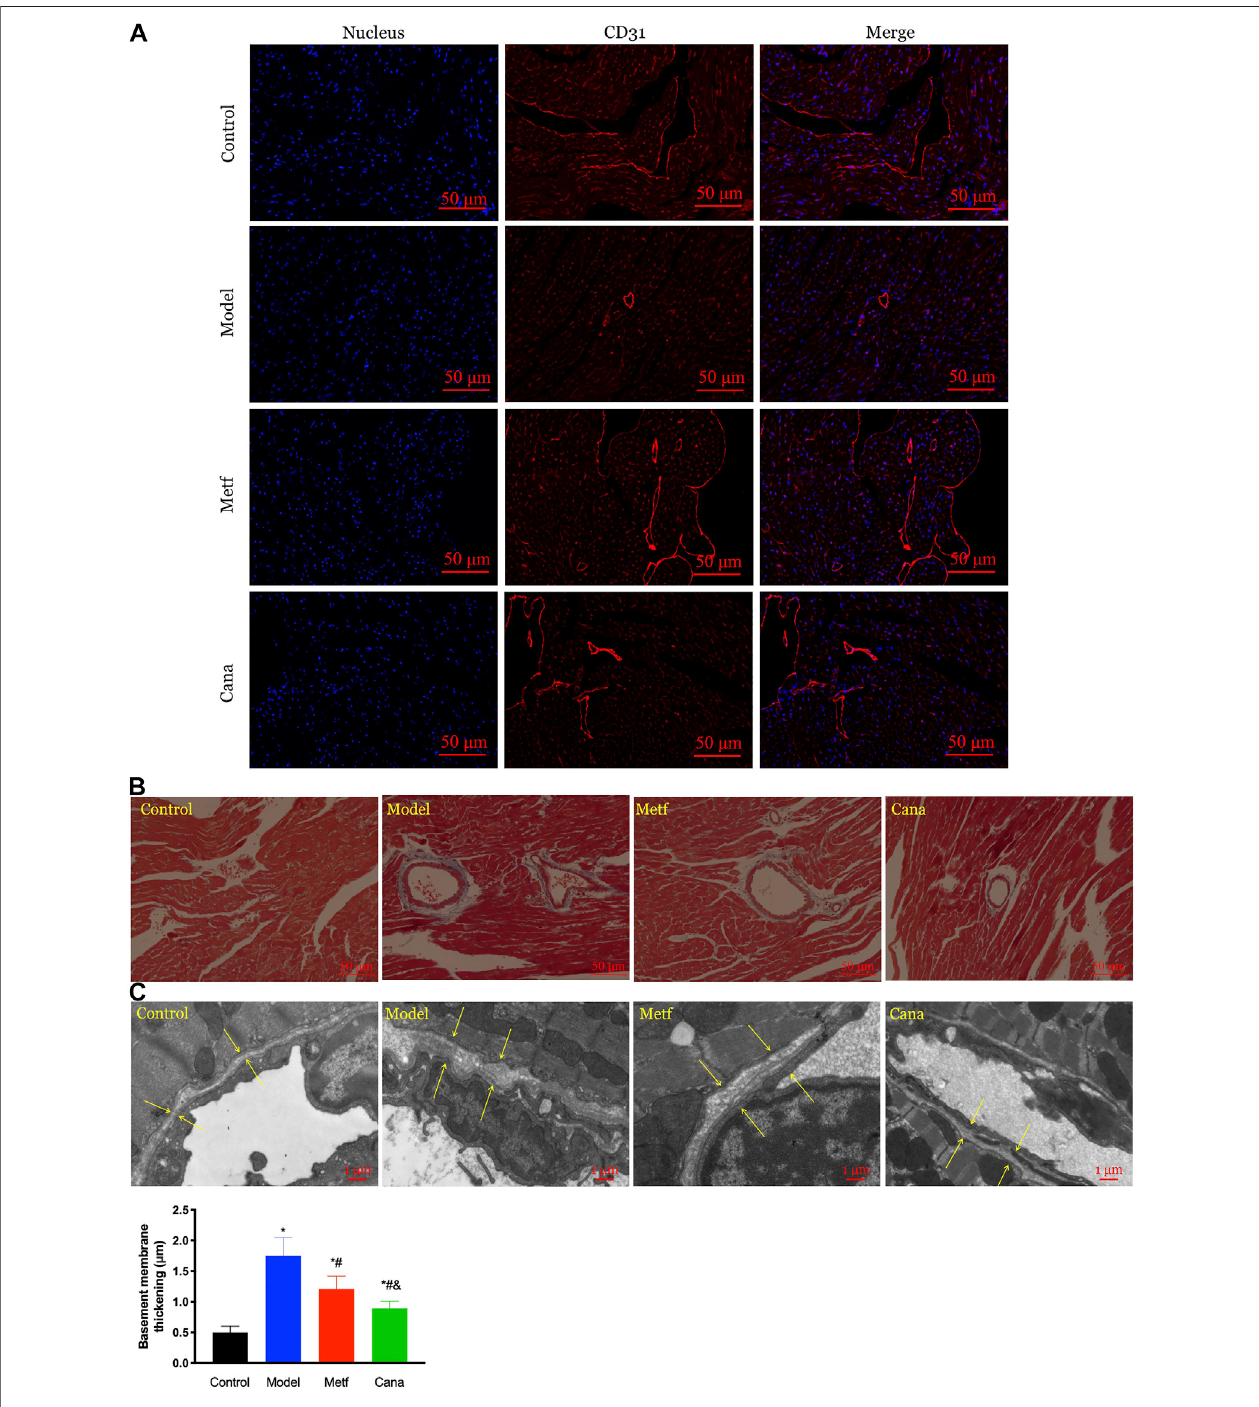
FIGURE 3 | Effect of Cana on cardiovascular abnormalities in T2DM mice. The expression of cluster of differentiation 31 (CD31) in cardiac tissues (A) , immuno fl uorescence staining for CD31 (red), and nucleus (blue), scale bar: 50 μ m. Masson ’ s trichrome staining in cardiac tissues (B) , scale bar: 50 μ m. Changes in vascular basement membrane observed by transmission electron microscope (TEM) (C) , scale bar: 1 μ m. & p < 0.05, the Cana group compared with the Metf group; # p < 0.05, compared with the model group; * p < 0.05, compared with the control group. Six mice in each group were randomly selected for analyses.